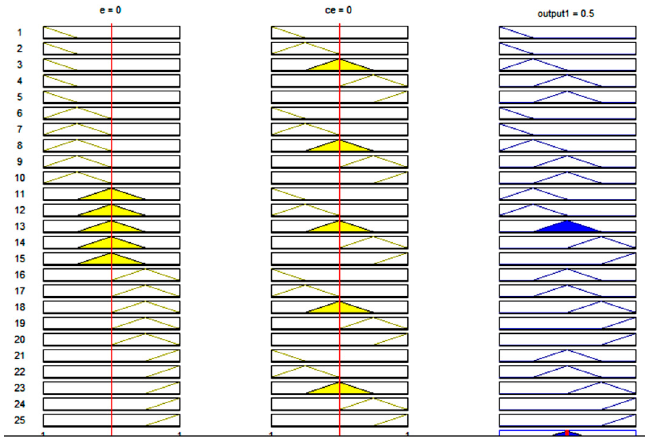
Figure 18. Rule viewer plot for Rule 2.